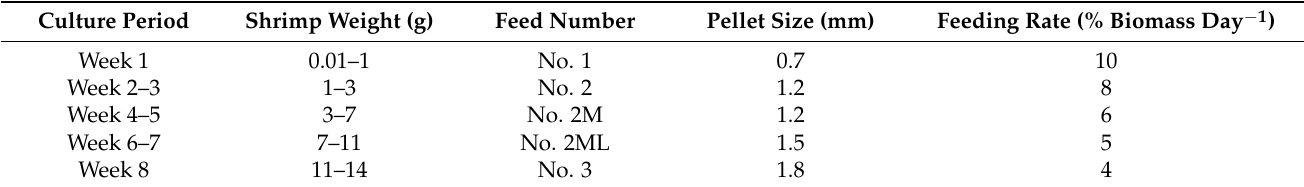
Table 1. Feeding information based on the Vannamei shrimp manufacturer (Grobest Company).